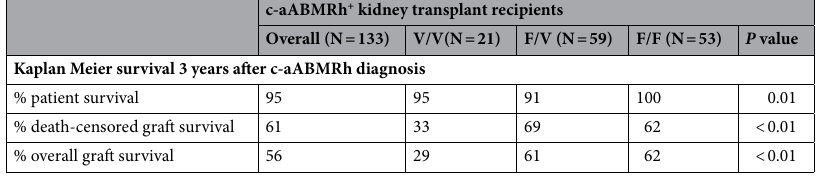
c-aABMRh + kidney transplant